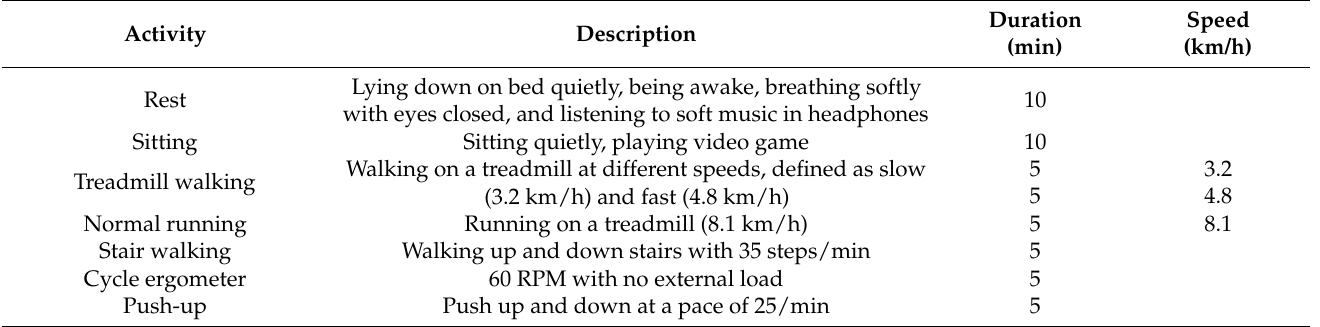
Table 2. Description of Exercise